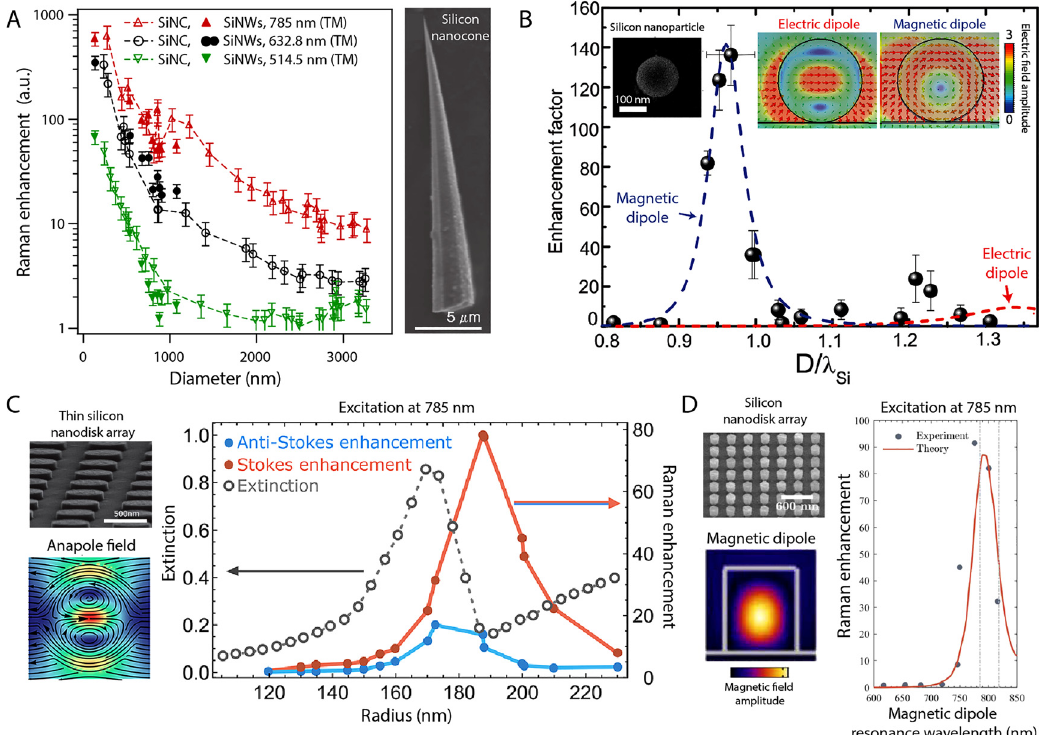
Figure 1: Enhancement of spontaneous Raman scattering in silicon nanostructures. (A) Raman enhancement in silicon nanowires and silicon nanocones of different diameters. The Raman measurements are performed with three different excitation wavelengths and with the incident electric fi eld polarized along the main axis of the nanowires (TM). Adapted from the study by Cao et al. [24]. (B) Raman enhancement due to Mie resonances in spherical silicon nanoparticles of different diameters D . When the ratio between the diameter and the wavelength in silicon λ Si is approximately unity, the magnetic dipole resonance is excited, which produceslargeinternal fi eldenhancements.AdaptedfromthestudybyDmitrievetal.[27].(C)Ramanenhancementduetotheanapolestatein thin silicon nanodisk arrays. The anapole state occurs due to the destructive interference between the incident light and the toroidal and electric dipoles in the nanodisks, leading to low far- fi eld radiation (extinction) and strong internal fi elds. Adapted from the study by Baranov et al. [30]. (D) Raman enhancement due to the magnetic dipole resonance in silicon nanodisk arrays. When the excitation laser wavelength matches the resonance wavelength of the magnetic dipole, a large enhancement in the Raman signal is observed. Adapted from the study by Matthiae et al.